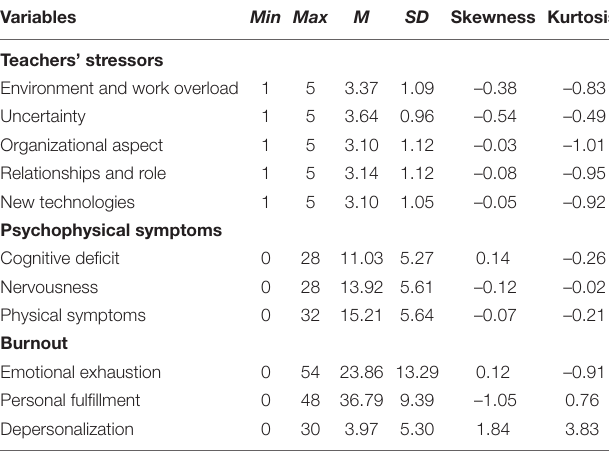
TABLE 2 | Descriptive information of the main